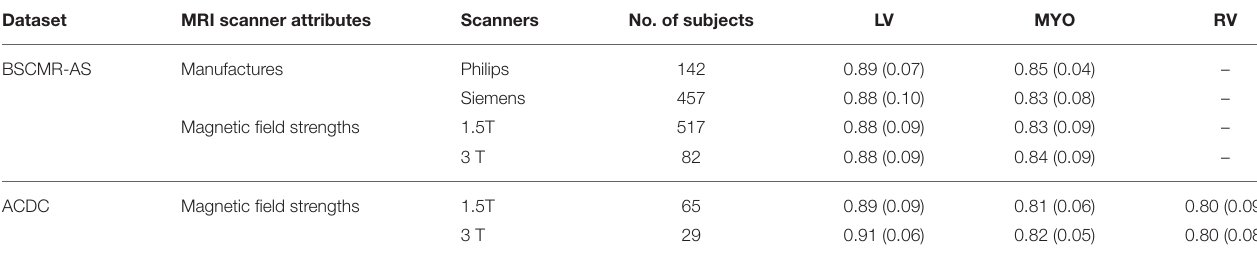
TABLE 6 | Segmentation performance of the UKBB model across different scanners.